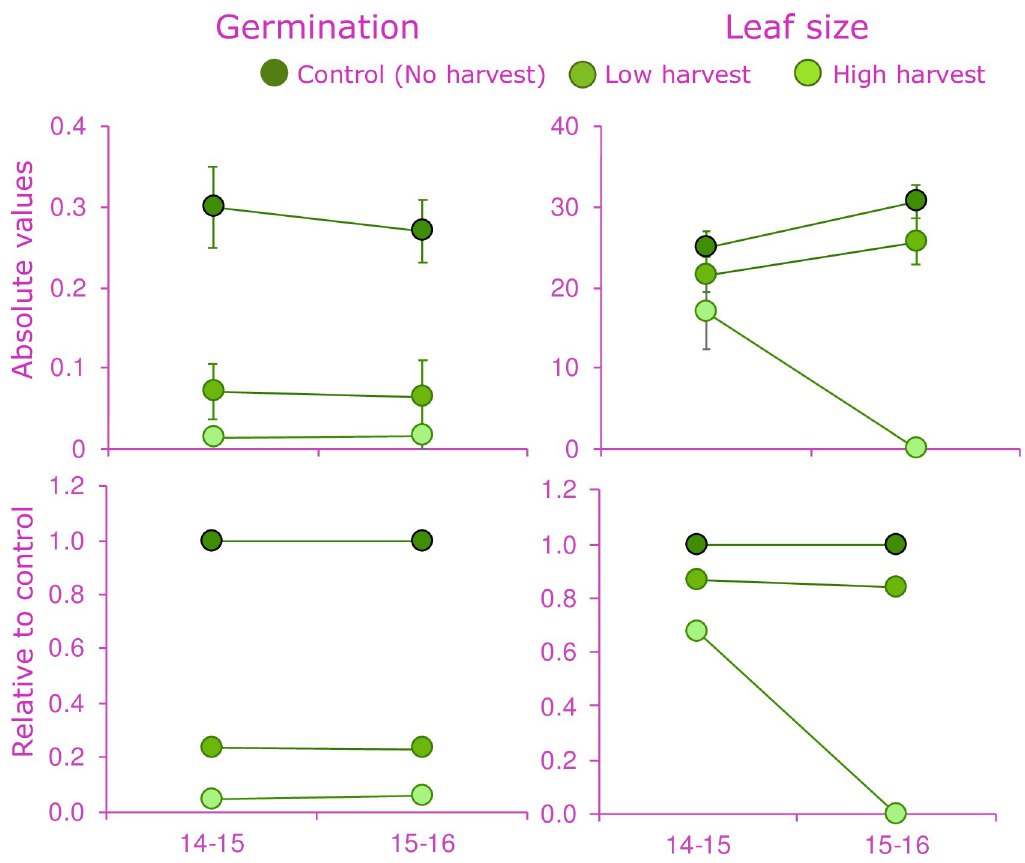
Fig 3. Variation in the performance of the progeny of Brahea aculeata under different experimental treatments of leaf harvesting in the dry forest of A´lamos, Sonora: Germination rate (germinated seeds mother-1 yr-1), b) Leaf length of seedlings (cm). Top charts indicated the absolute values, while bottom charts indicated the proportional change compared to the control treatment for each year. At the bottom charts, the no harvest treatment (Control) is used as a